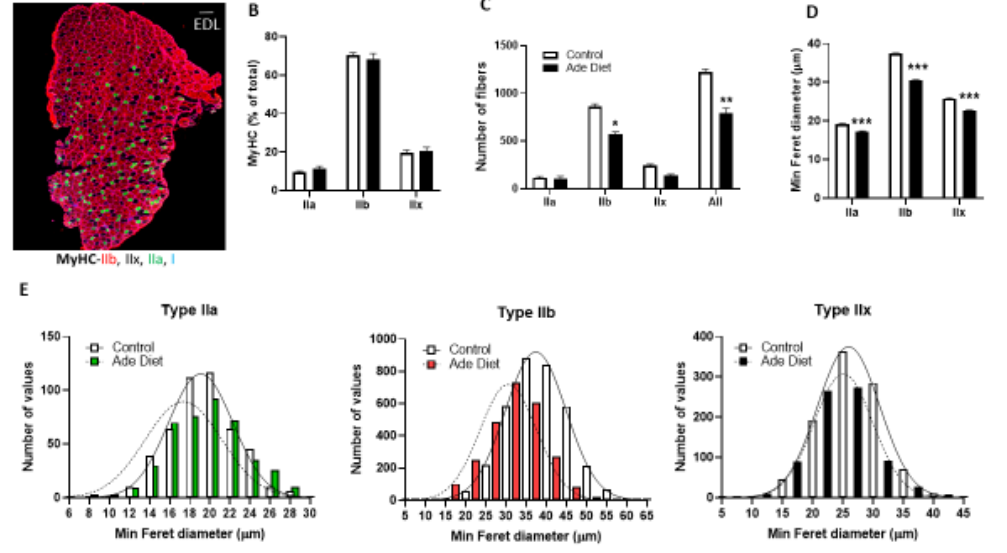
Figure 2. Extensor digitorum longus (EDL) muscle fibers characteristics in mice with kidney disease. Mice were exposed to a 0.2% adenine-containing diet to induce kidney disease. Muscle fiber composition and structure were compared between mice that were exposed to adenine versus control diet. ( A ) Representative photograph of EDL muscle myosin heavy change (MyHC) staining in control mice (Scale bar = 100 microns). ( B ) Relative fiber-type composition ( C ) Number of fibers. ( D ) Minimum Feret diameter. ( E ) Frequency histograms of fiber size of EDL muscles measured as minimum Feret diameter (n = 4 in each group measuring all the fibers in each section). Unpaired t test with Welch’s correction (Type IIA fibers) and Mann–Whitney test (Type IIB and IIX), error bars represent SEM * p ≤ 0.05, ** p < 0.01, *** p < 0.001.